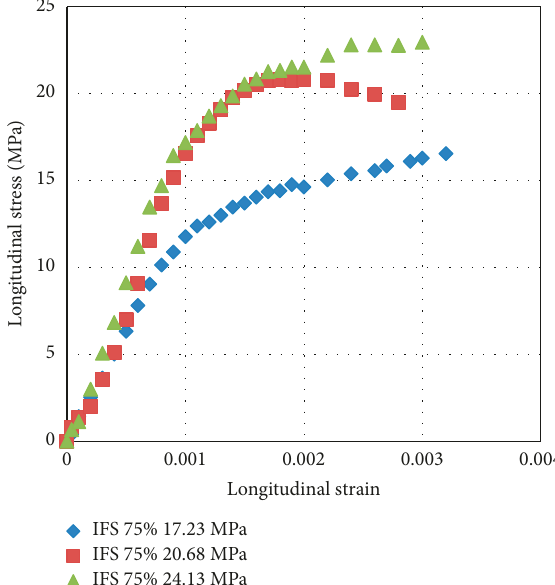
Figure 21: Longitudinal stress-strain diagram RAC with 75% IFS.